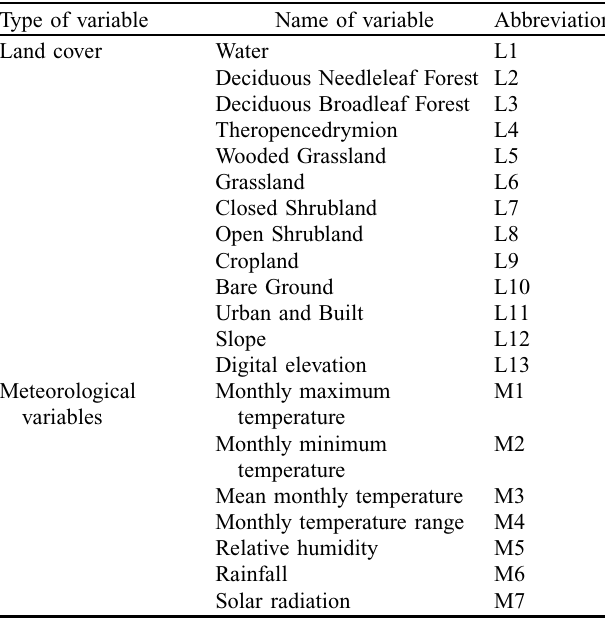
Table 1. Risk variables inputted into the model.